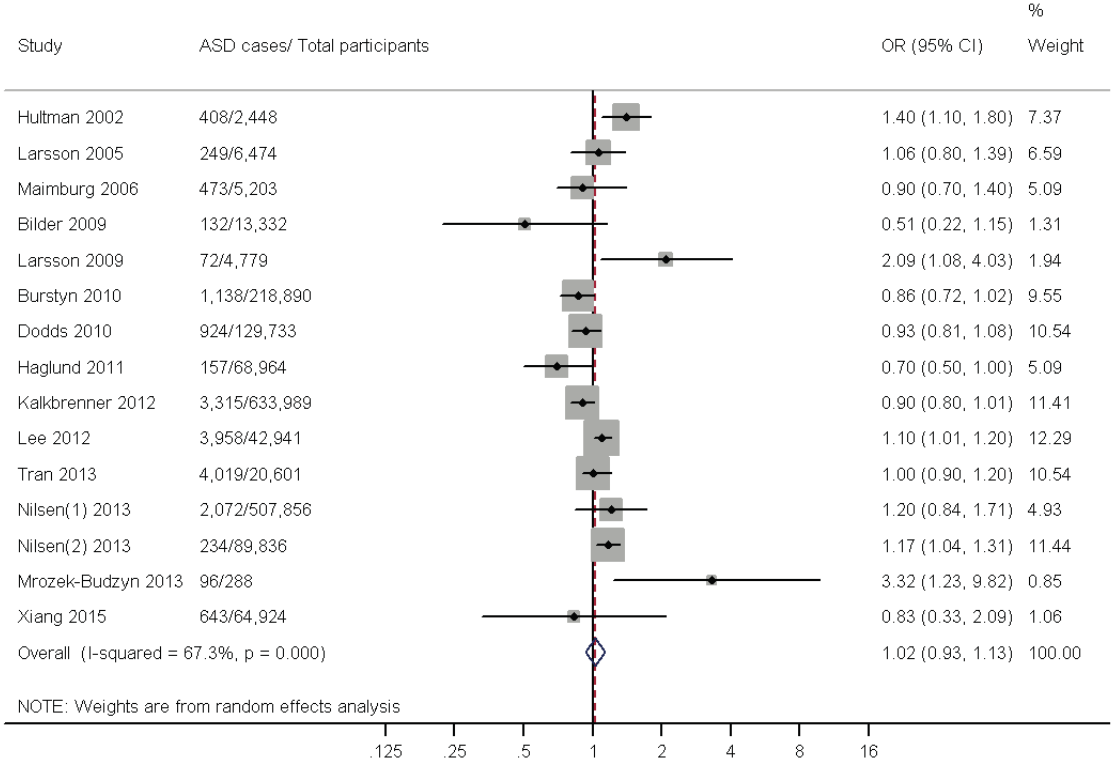
Figure 2. A forest plot of the association between maternal smoking during pregnancy and ASD